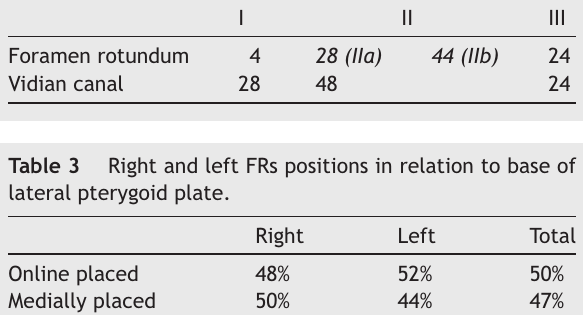
Types of vidian canal and foramen rotundum.